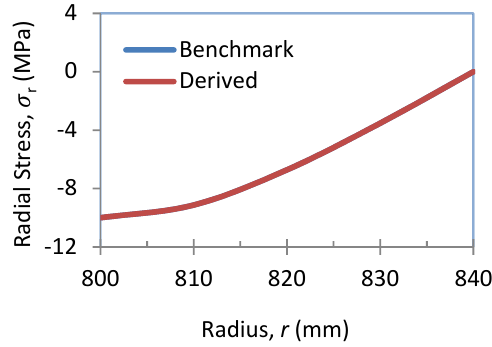
Figure 2. The variation of radial stress with cylinder radius.